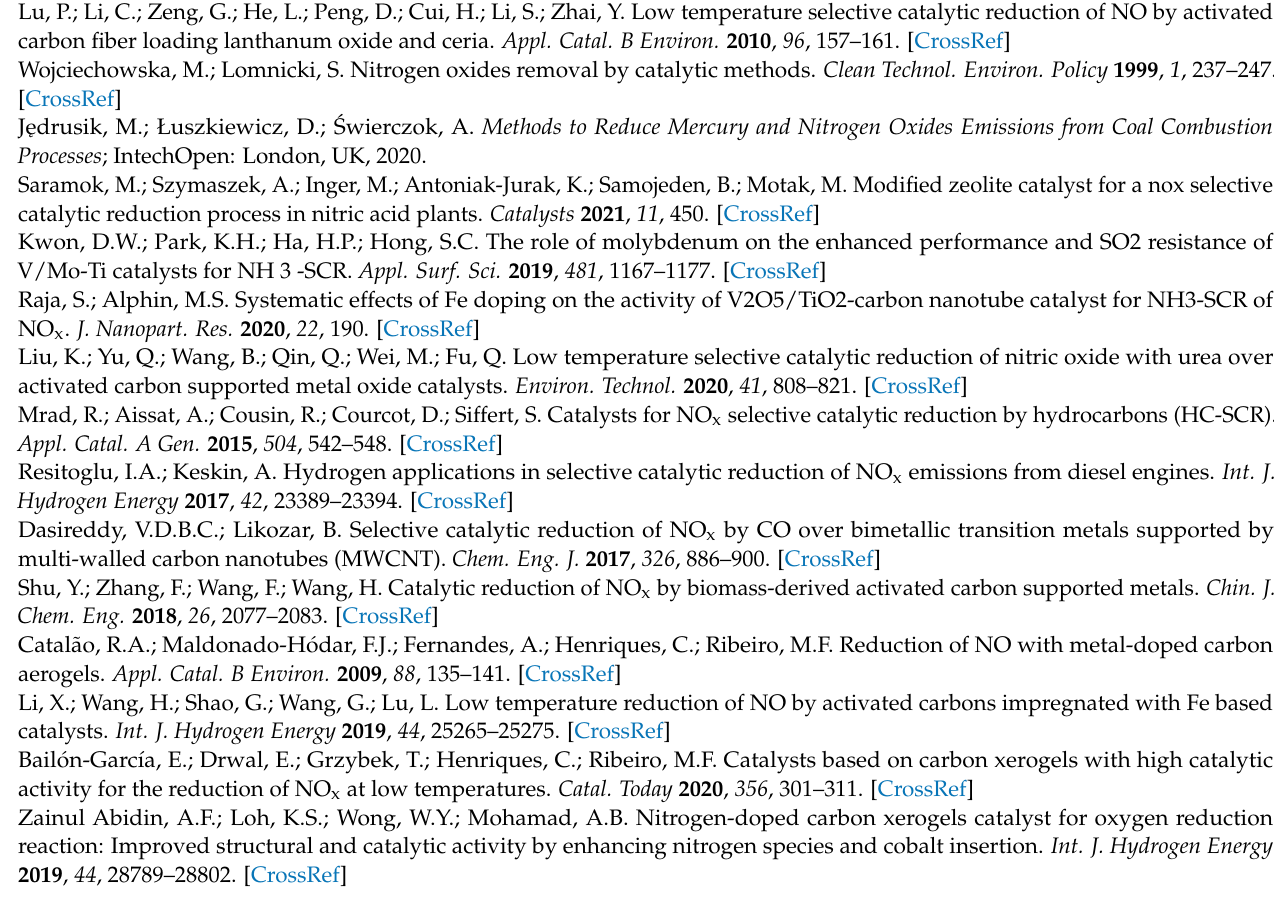
Analyzing the results of Figure A4, between 200 and 250 ◦ C the reduction of NO increases with the increase in the concentration of O 2 used; however, for temperatures above 250 ◦ C the increase in the concentration of O 2 is significant when it increases from 5 to 10% but increasing this parameter beyond 10% has no positive influence on the NO conversion. The maximum conversion of NO obtained for 5 and 10% is 95% at a temperature of 350 and 338 ◦ C, respectively. The mass of the MF samples lost during the reaction increases with the increase in the concentration of O 2 in the gas stream due to the gasification of the sample, which shows that the samples are less stable in the presence of a greater amount of O 2 . Although the maximum conversion temperature in the MF_U_10Cu_10_O 2 test is slightly lower than in the MF_U_10Cu_5_O 2 test, the results obtained at 5% O 2 are also quite attractive and the stability of the samples is higher, which makes the increase of the oxygen concentration in the NO stream